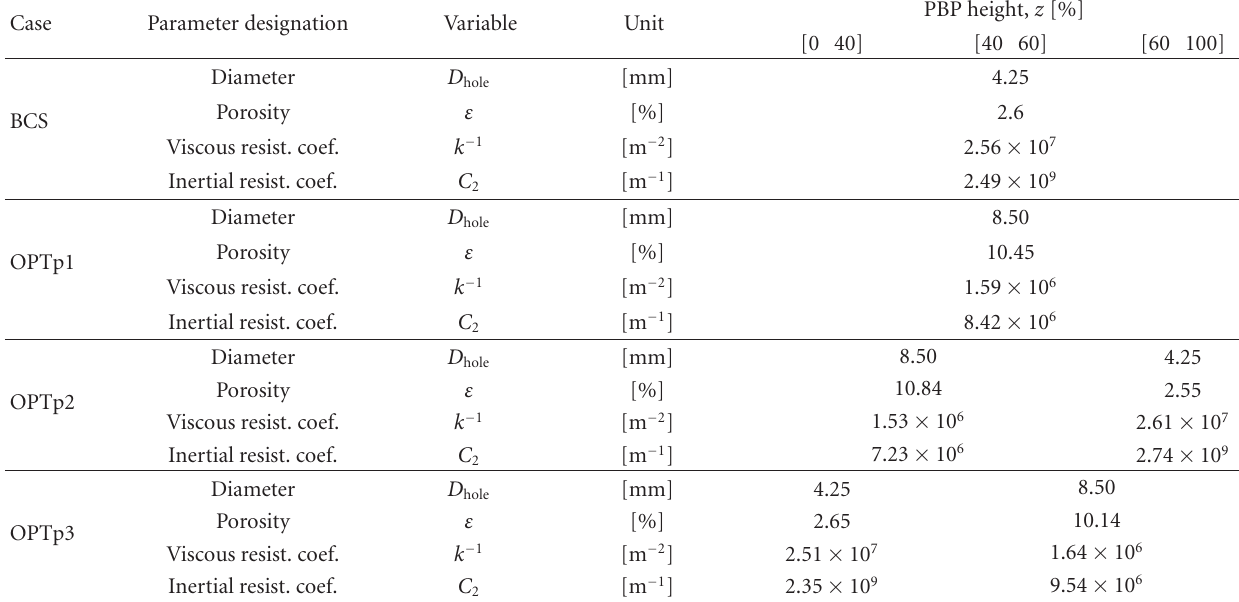
Table 6: Parameters specified at PBP boundary conditions—OPTp case